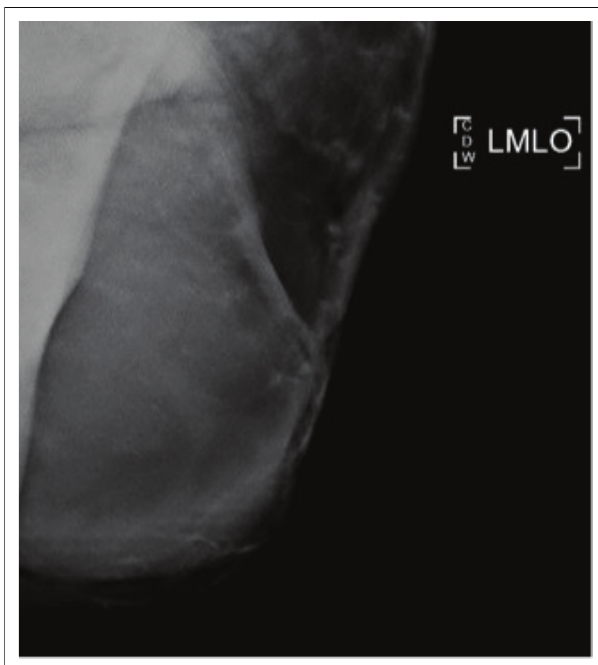
FIGU RE 4: Post-surgical, medio-lateral oblique view of the left mastectomy scar demonstrating a hyper-dense mass within the axillary tail.